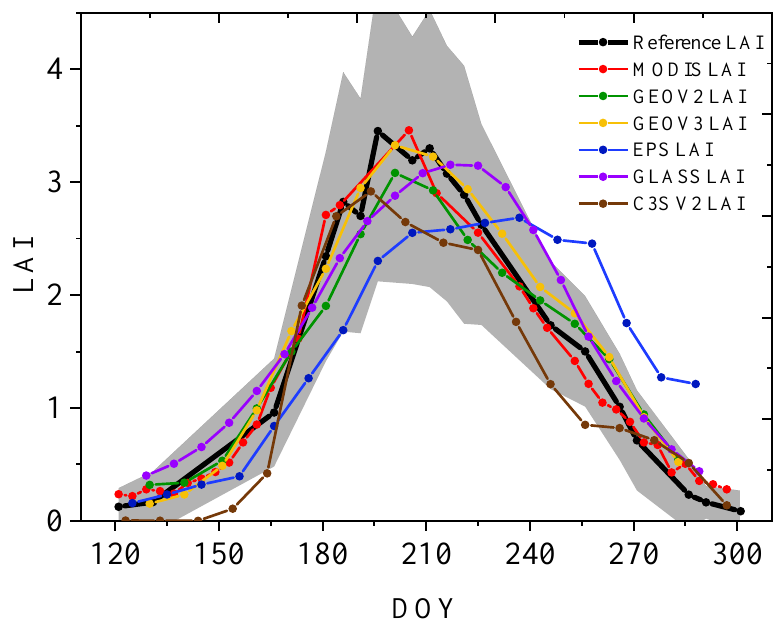
Figure 8. Time series of reference LAI, MODIS, GEOV2, GEOV3, EPS, GLASS and C3S V2 LAI products. The shaded gray area represents the uncertainty of reference LAI. Table 2. Timing (day of year, DOY) for the start of season (SoS), the peak of the growing season (PoS) and the end of season (EoS) for the different LAI products. In parenthesis, the bias in days as compared to the reference LAI phenology is indicated.